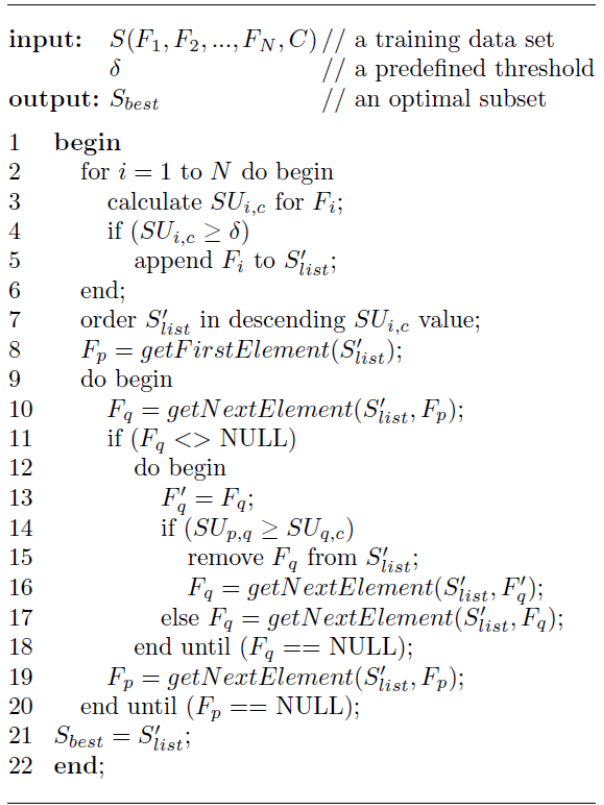
Figure 4. FCBF Algorithm